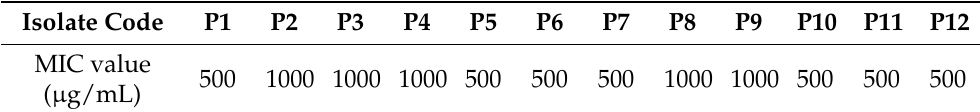
Table 2. MIC values of frankincense extract against P. gingivalis isolates.